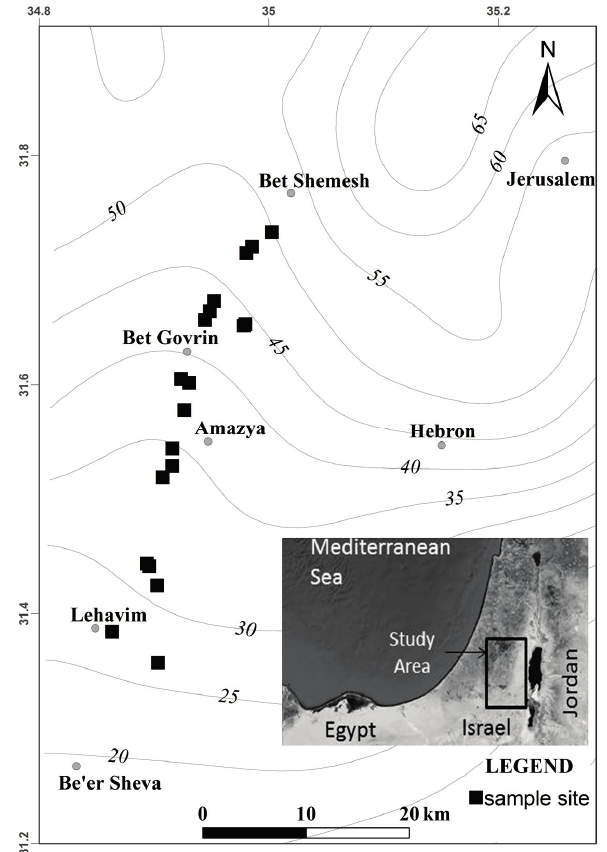
Figure 4. Precipitation levels (cm/yr) across the study area, with the location of 23 field sampling sites.